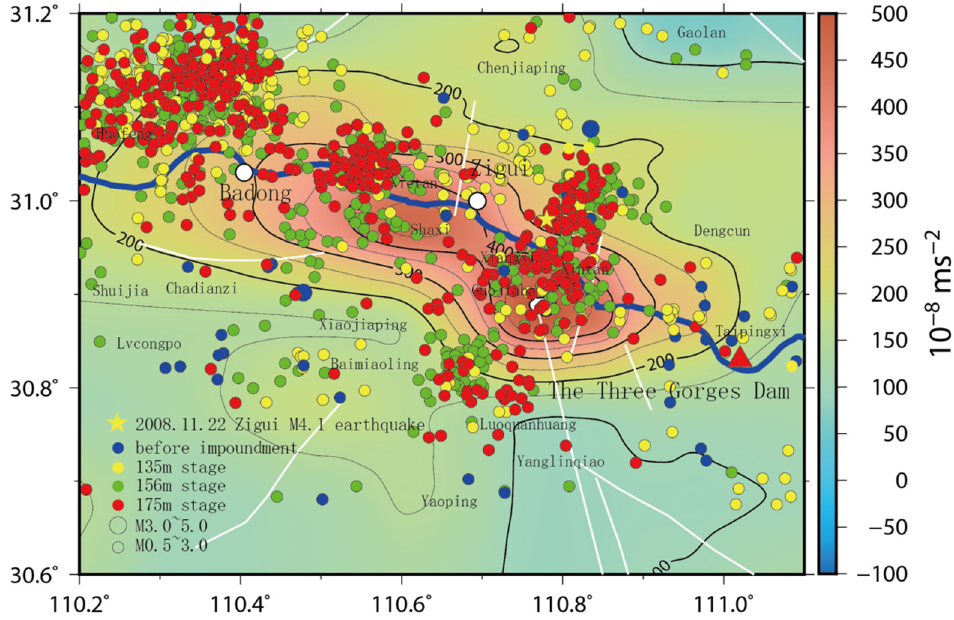
Figure 8. Changes in the gravity field (October 2001–November 2008) and seismicity.